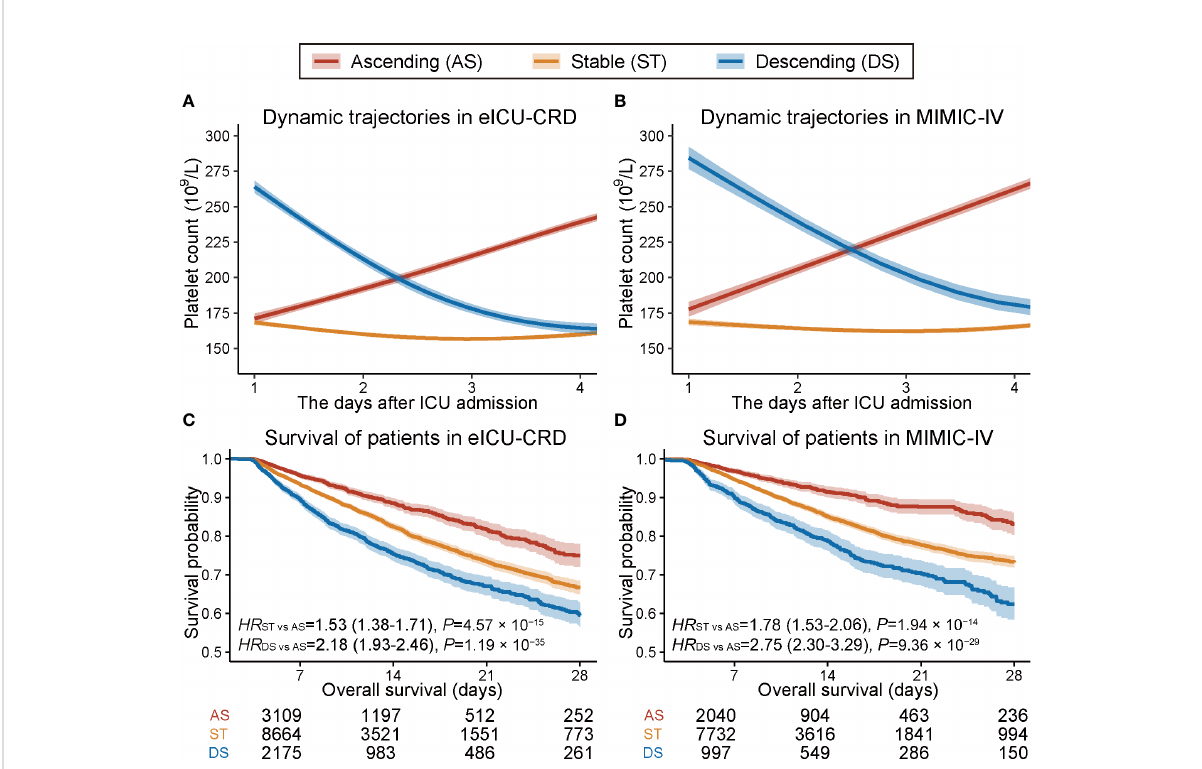
FIGURE 1 Trajectory plot and Kaplan – Meier survival curves of patients with three dynamic platelet count trajectory patterns. (A, B) Trajectory plot of platelet count changes within the fi rst four days after ICU admission in eICU-CRD and MIMIC-IV databases. (C, D) Kaplan – Meier curves of 28- day overall survival for patients with three different dynamic platelet count trajectory patterns in the eICU-CRD and MIMIC-IV